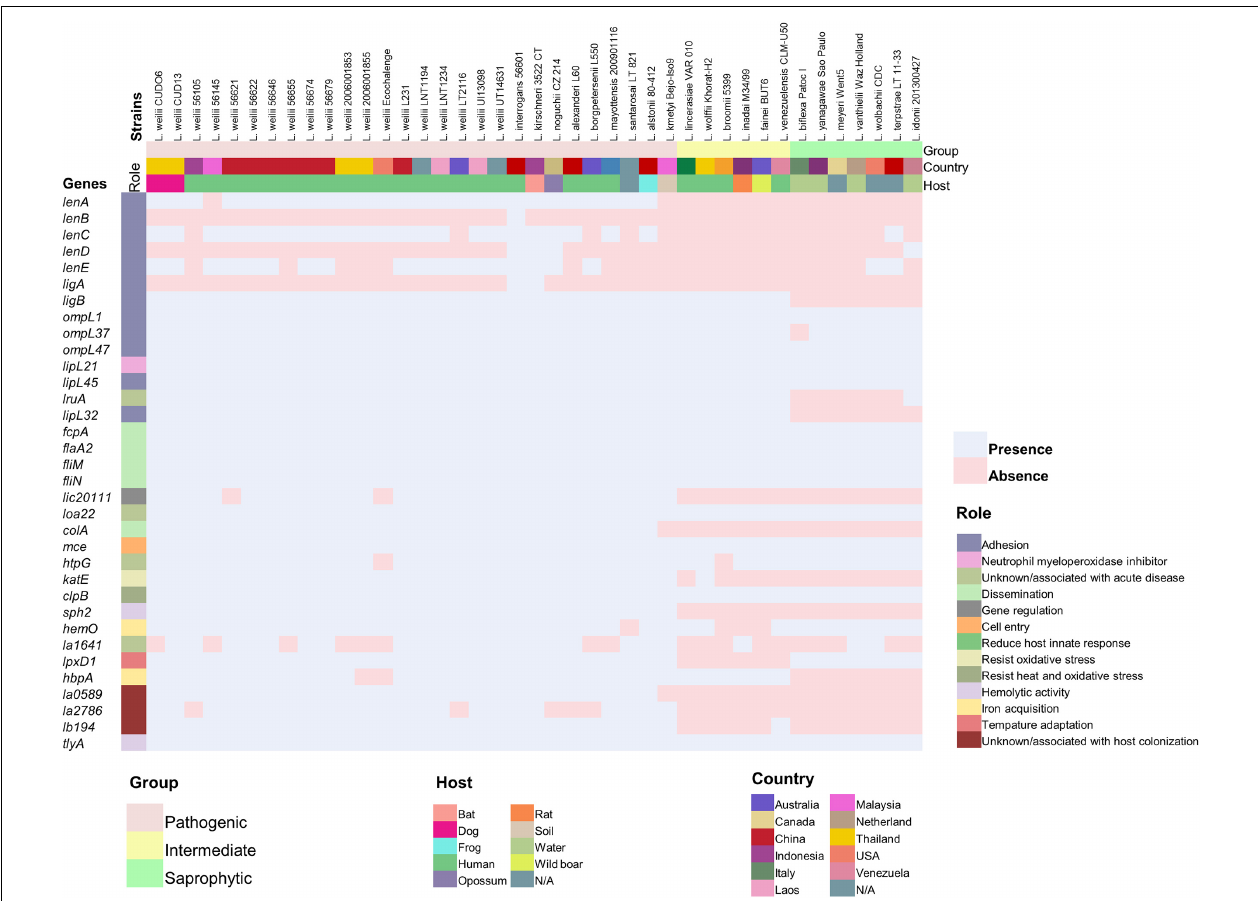
FIGURE 4 | Distribution of the 34 representative confirmed virulence genes across 41 strains of pathogenic, intermediate, and saprophytic Leptospira . The representative confirmed virulence genes in each strain were determined using the deduced amino acid sequence obtained from the UniProt database and BLASTp algorithm. Presence and absence of genes are represented by colored pale pink and pale blue boxes, respectively. The distinct Leptospira group, source of isolation (country and host), and role of the confirmed virulence genes are represented by different colors. The L. weilii serogroup Mini strain CUD13 contained all of the representative confirmed virulence genes, while strain CUDO6 contains all except the gene corresponding to acute infection ( la1641 ).